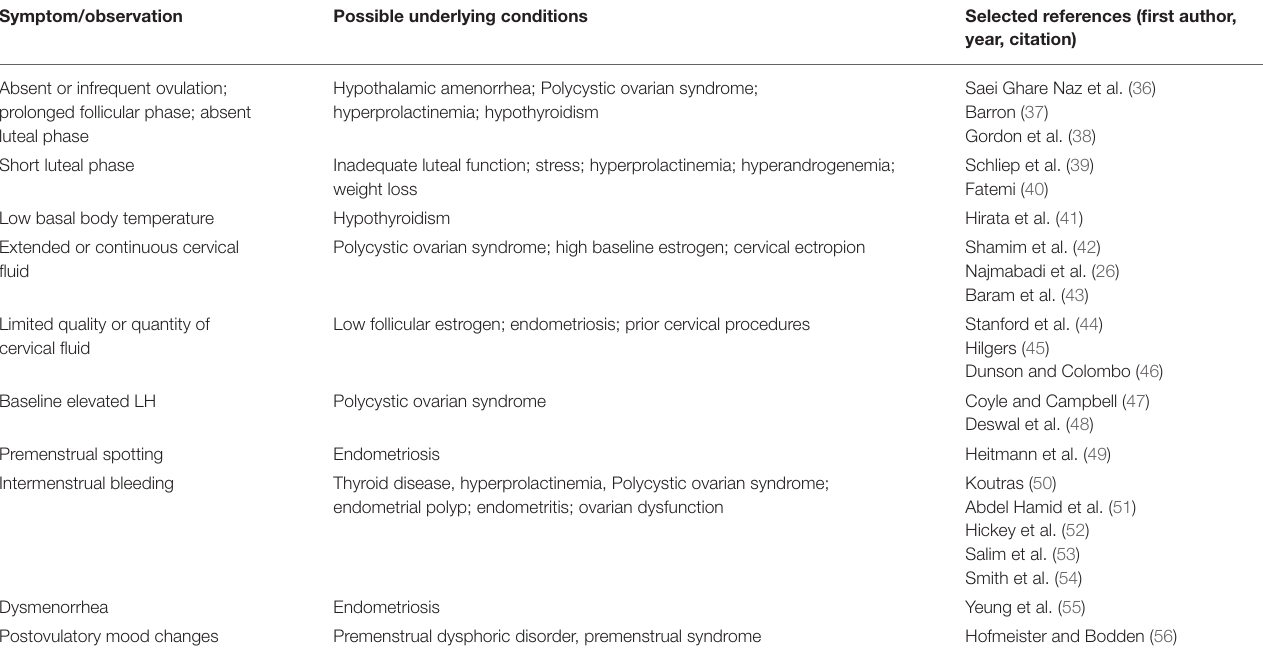
TABLE 2 | Cycle parameters observable with fertility awareness-based methods and associated underlying health